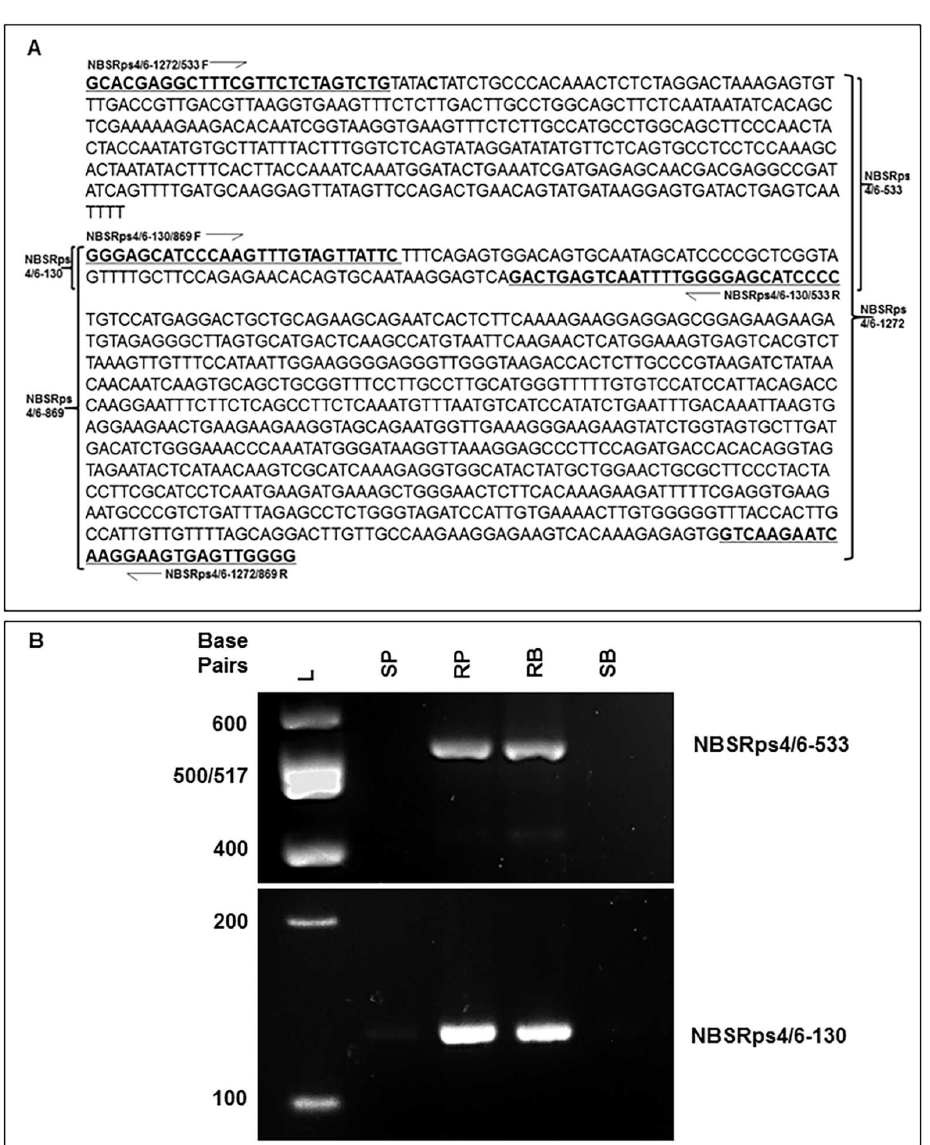
Fig 3. Analysis of NBSRps4/6 -specific molecular markerslinked to a novel Phytophthora resistance gene. (A) The NBSRps4/6 specific sequence(GenBank accessionno. AY258630[50]) used for developing molecularmarkers. Primer sequencesused for PCR are underlinedand marked with half arrows. The PCR primers for amplifiedtargets, NBSRps4/6-1272, NBSRps4/6-869, NBSRps4/6-533 and NBSRps4/6-130, are shown along the primers (S2 Table). (B) The NBSRps4/6 specific molecularmarkers linkedto the novel Rps gene. L, 100 bp DNA Ladder(New EnglandBiolabs, USA); SP, susceptibleparent AR2; RP, resistant parent PI399036; RB, bulk of 10 resistant homozygousRILs; SB, bulk of 10 susceptible RILs. NBSRps4/6-533, NBSRps4/6 specific NBSRps4/6-533 marker; NBSRps4/6-130, NBSRps4/6 specific NBSRps4/6-130